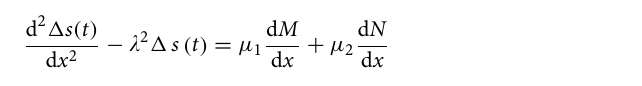
Figure 3. Influence of coupling stiffness under creep on interface slip